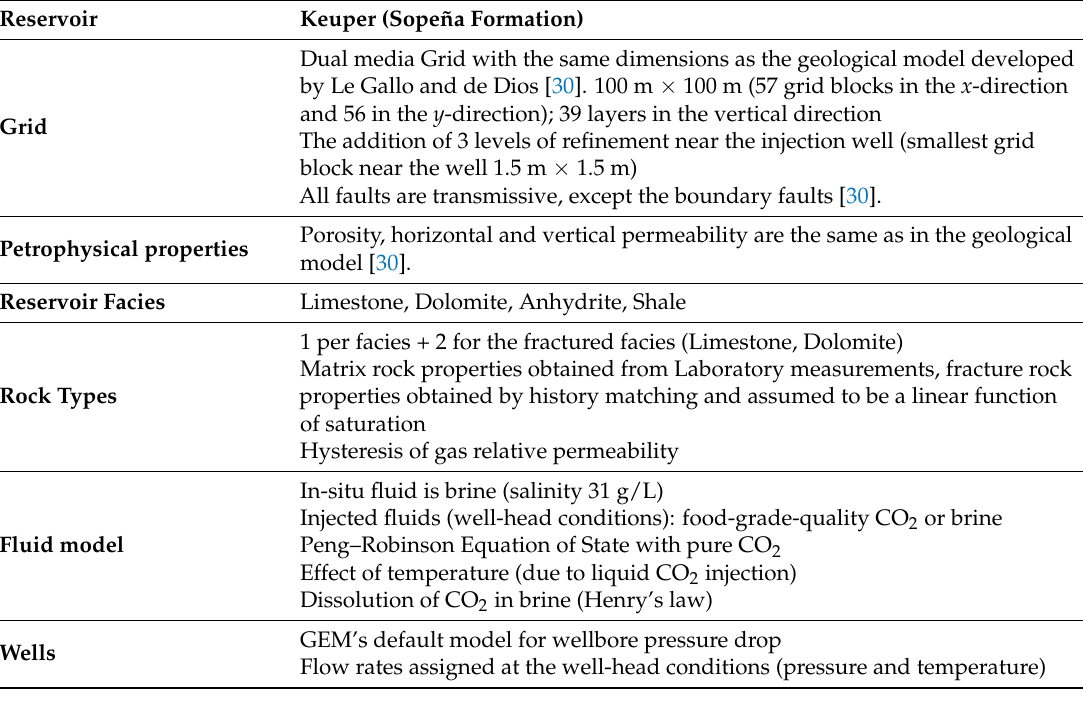
Table 4. Dynamic